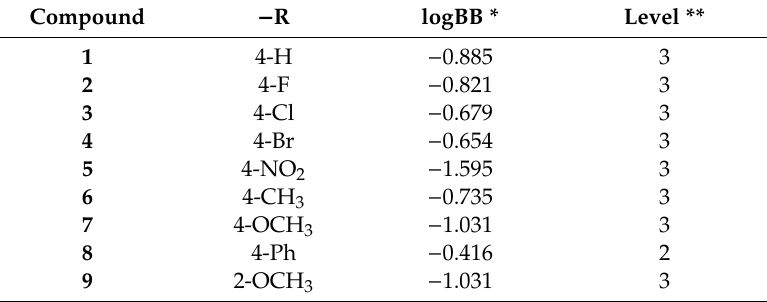
Table 1. In silico prediction of tested nicotinamide derivatives ( 1 – 9 ) passive transport to central